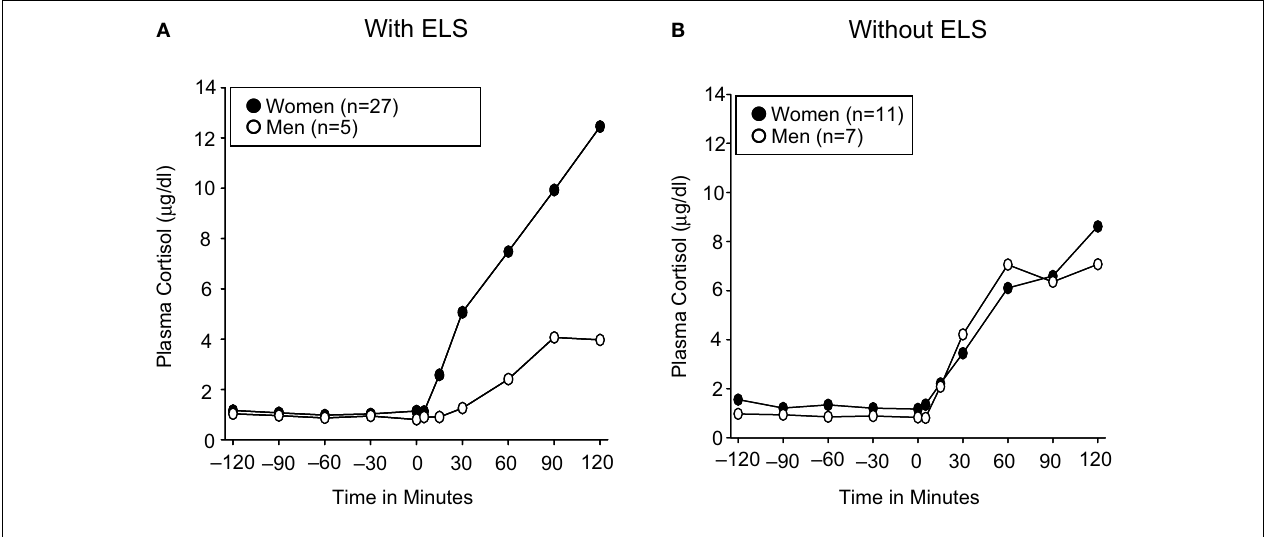
FIGURE 4 | Effect of sex on cortisol response in dexamethasone/CRH test in carriers of the CRHR1 rs110402 A allele with ( N = 32) and without ( N = 18) histories of childhood trauma. Graph depicts mean plasma cortisol concentrations (µg/dl) in subjects grouped by sex. (A) In A allele carriers with moderate-severe childhood trauma exposure, repeated measures ANOVA revealed